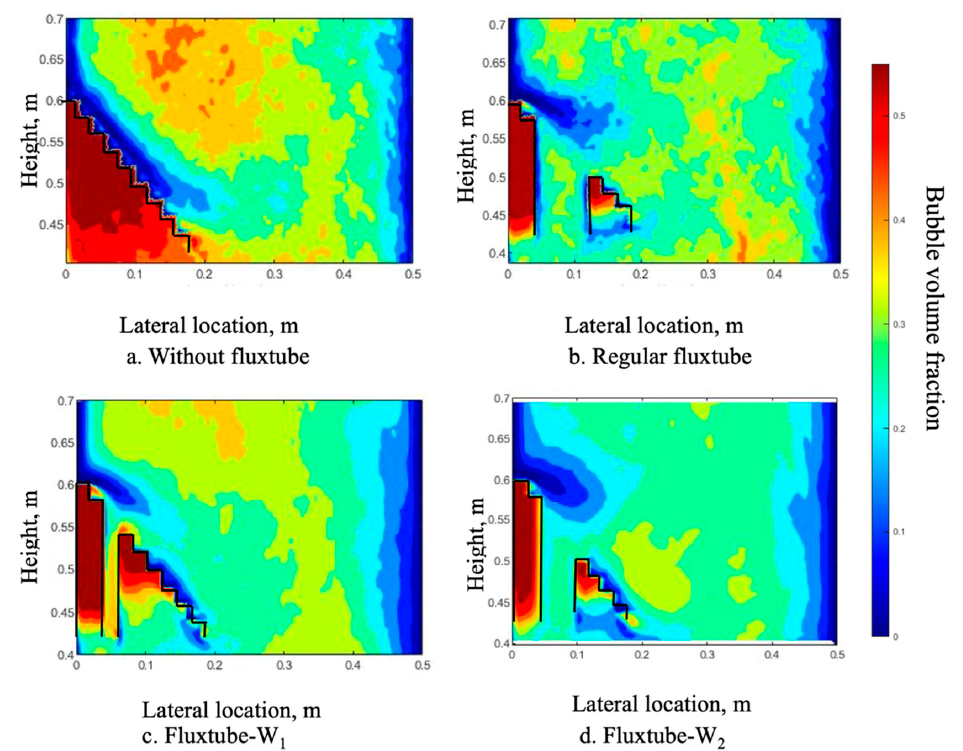
Figure 16. Bubble volume fraction contours at the baffle zone (0.40 m < y < 0.70 m) using the asymmetrical baffle without a fluxtube and with fluxtubes of different widths under the superficial gas velocity of 0.4 m/s for the even gas inlet